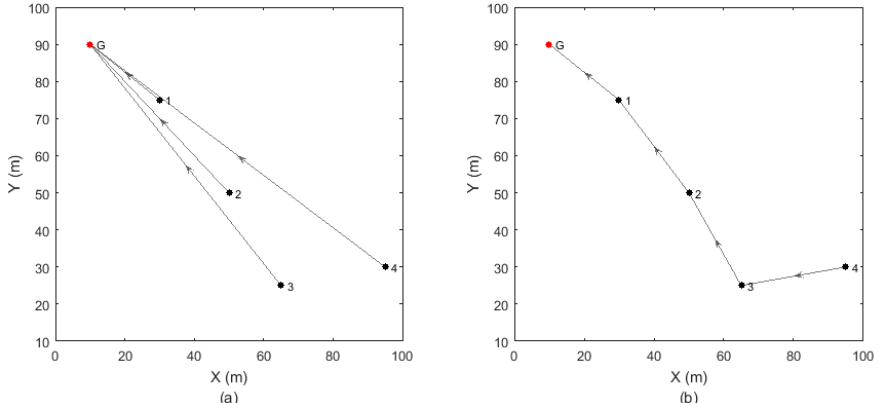
Figure 15. Different network topologies: ( a ) Single-hop: each node (black dots) communicates directly to the gateway (red dot); ( b ) Multi-hop: the nodes communicate to the gateway hopping through other nodes.